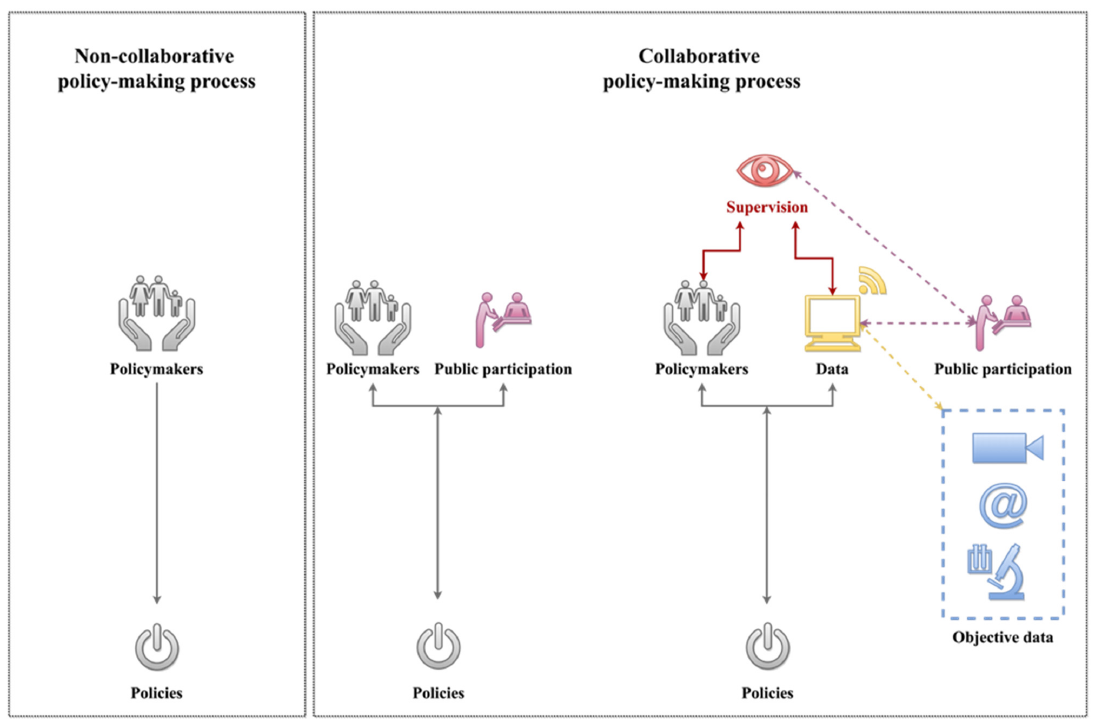
Figure 1. A schematic representation of noncollaborative and collaborative policy-making processes.